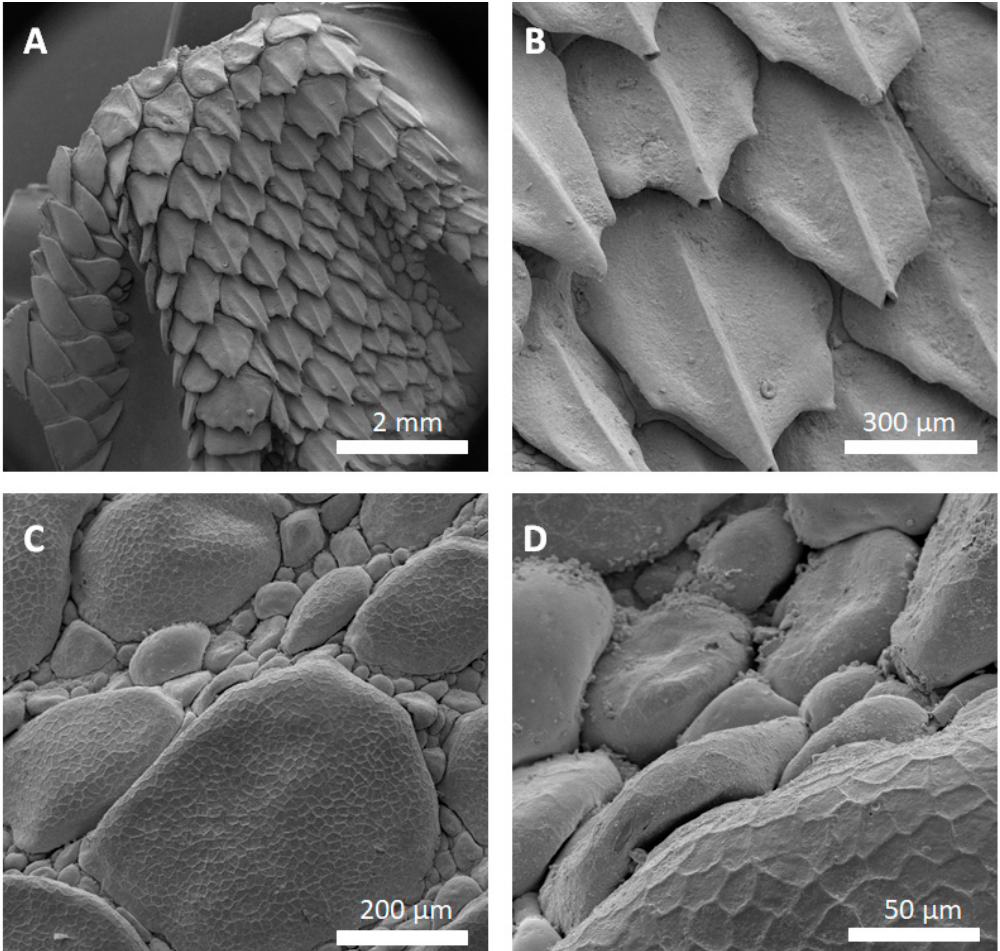
Figure 4. All-metal replica from the skin of P. cornotum . ( A ) SEM image of the foot scales’ replica; and ( B ) higher magnification SEM image. Minor defects as missing scale tips and small bubbles are observed. ( C ) SEM image of the dorsal scales’ replica; and ( D ) higher magnification SEM image. Successful replication of the lizards scales’ micro-ornamentation is clearly visible.